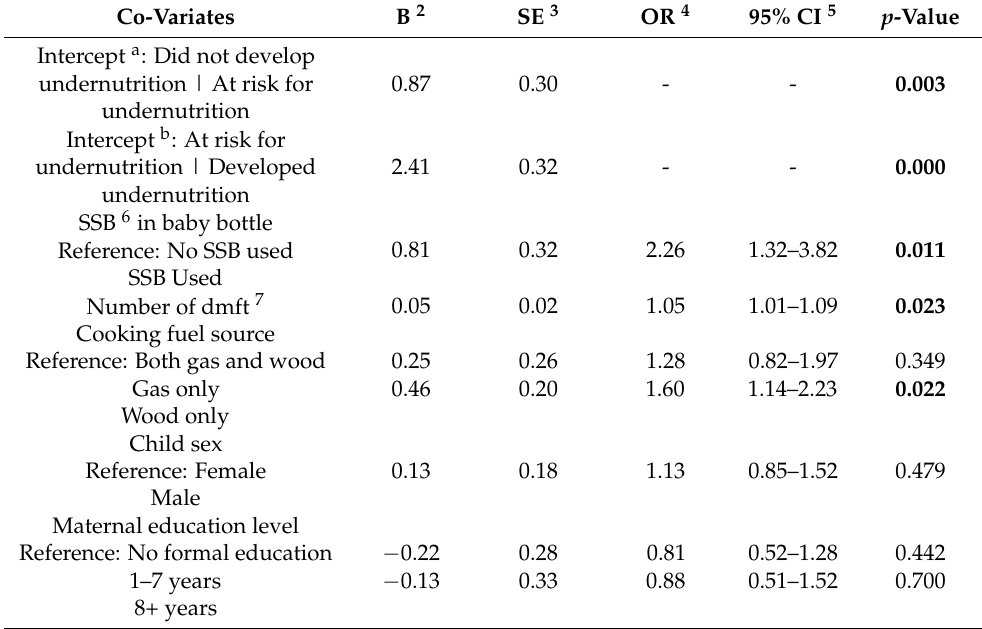
Table 4. Risk factors for child underweight (low WAZ) 1 outcome ( n = 563). Co-Variates B